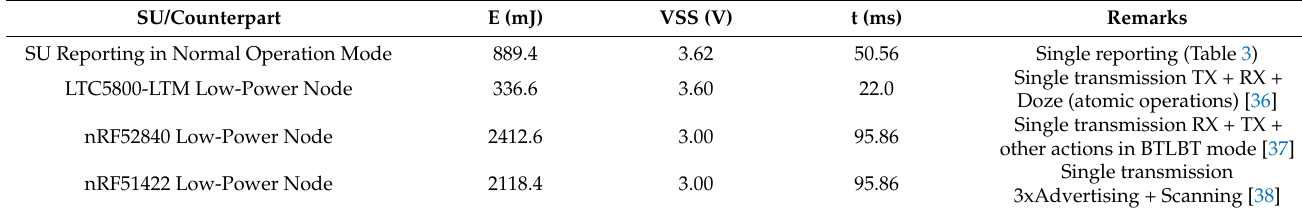
Table 5. Power requirements comparison of similar network